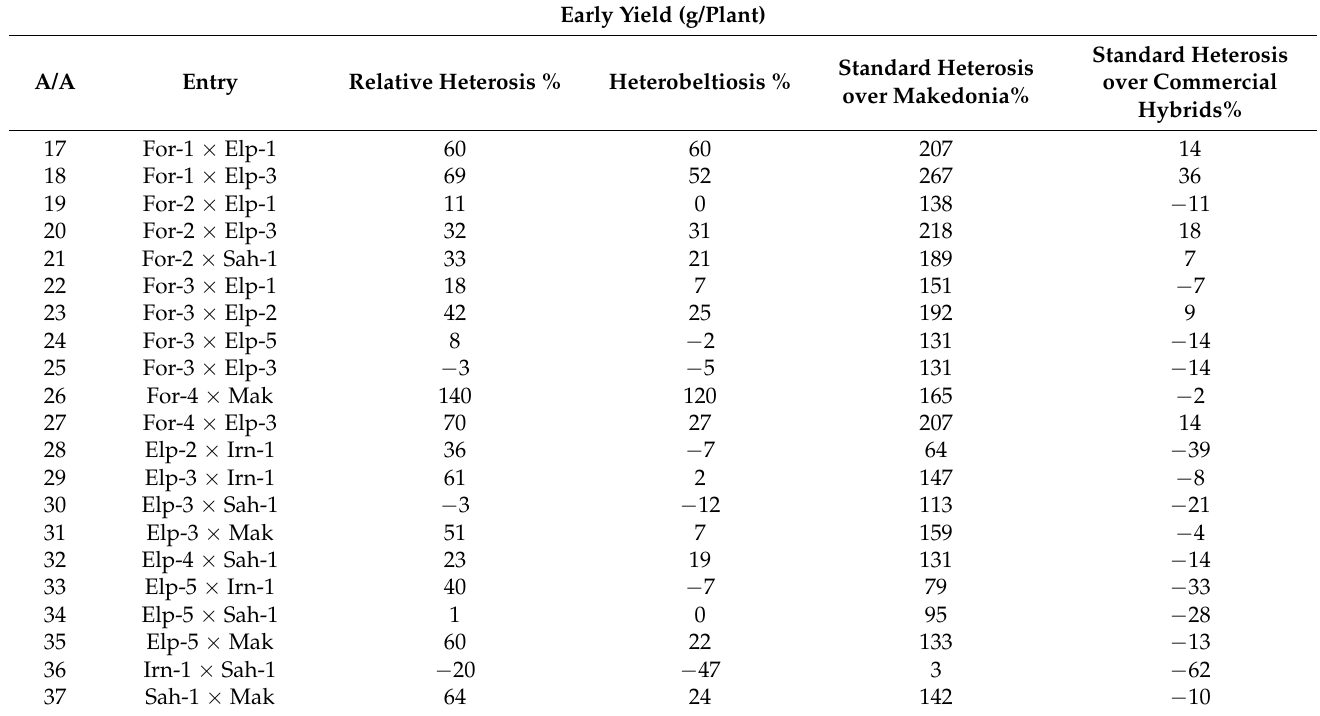
Table 4. Relative heterosis, heterobeltiosis, and standard heterosis of the reconstructed new hybrids for early yield (g/plant).